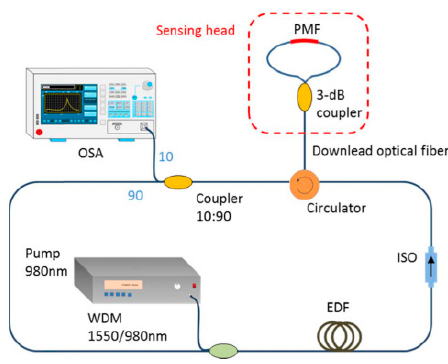
Figure 11. Schematic configuration of the multi-wavelength erbium-doped ring fiber laser based on an all fiber intrinsic Fabry–Perot interferometer.